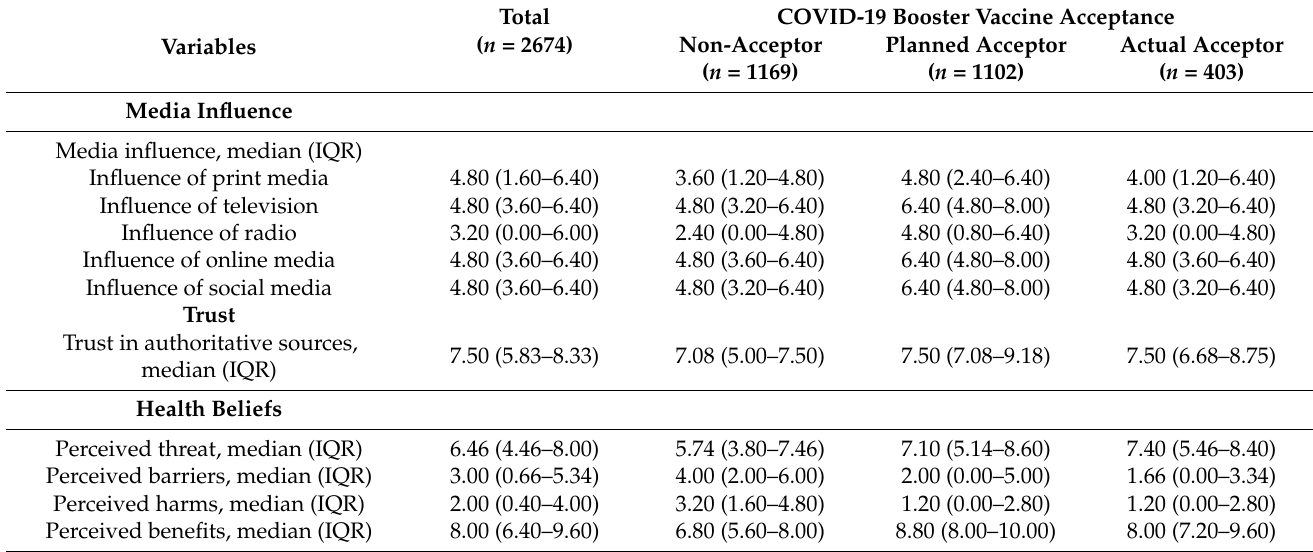
Table 2. Media influence, trust, and health belief scores (range from 0 to 10) among